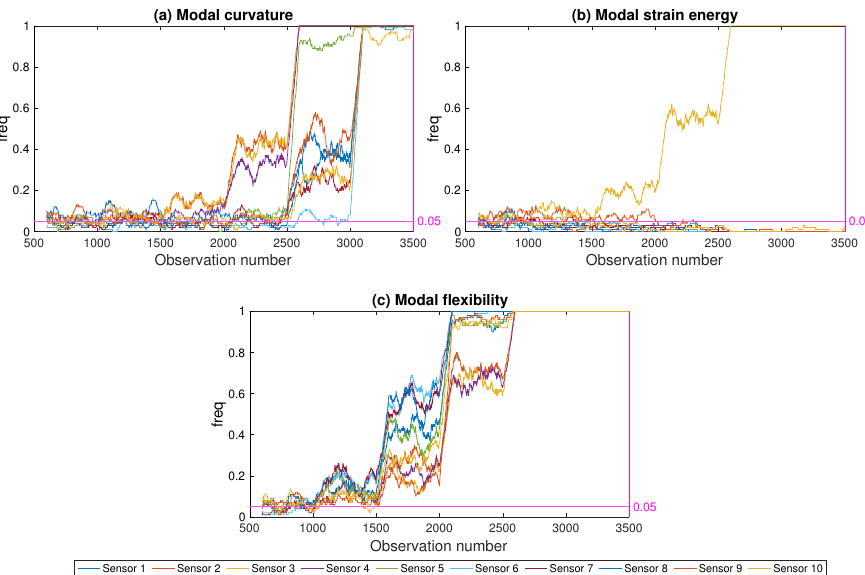
Figure 14. Effect of damage indicator; damage at the mid-span; 5%